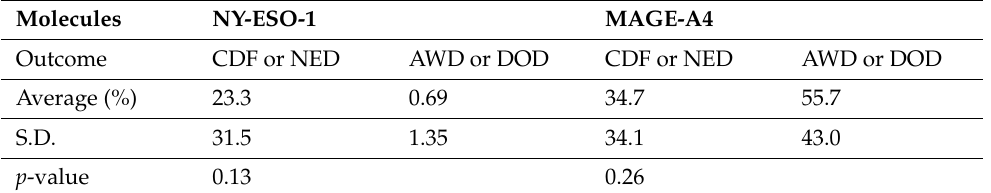
Table 2. Expression of NY-ESO-1 or MAGE-A1 in continuously disease-free cases or those without evidence of disease in comparison with alive with disease or died of other cause cases. Molecules NY-ESO-1 MAGE-A4 Outcome CDF or NED AWD or DOD CDF or NED AWD or DOD Average (%) 23.3 0.69